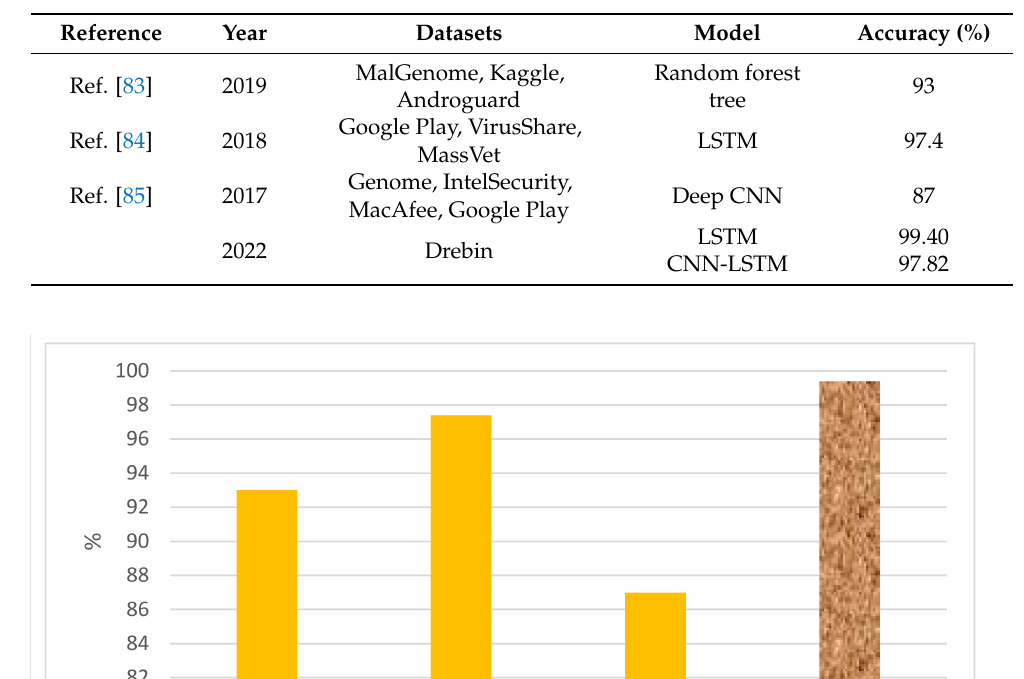
Table 14. Results of the proposed system against existing security systems using different Andriod datasets.